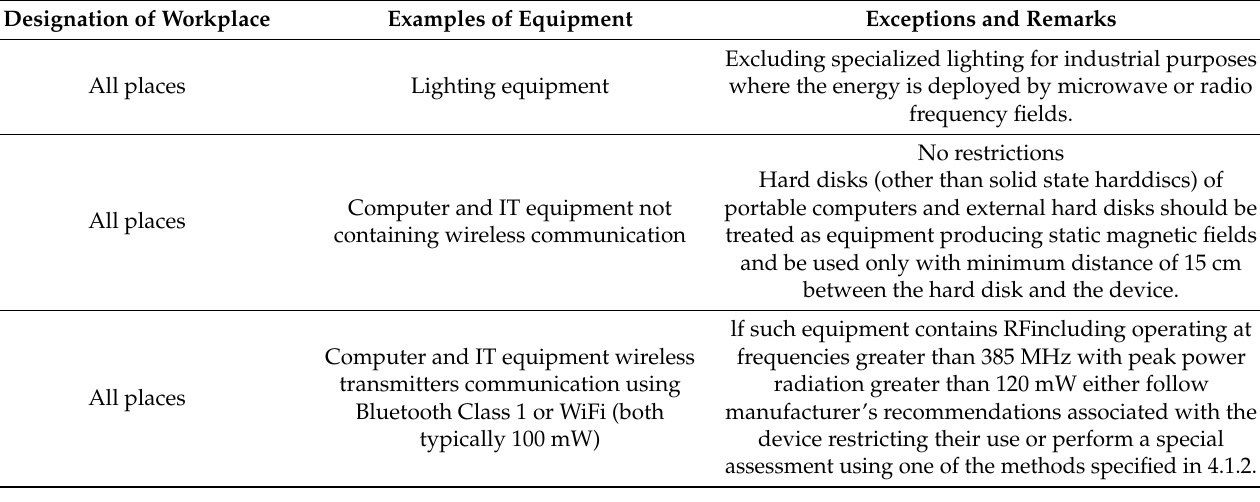
Table 3. Extract from Table A.1 of the EN50527-2-2 [15] standard, showing the specific indications for Wi-Fi and Bluetooth